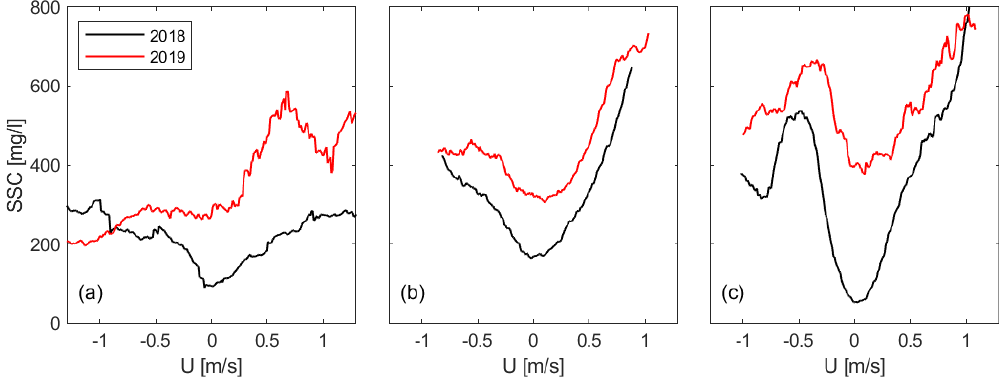
Figure 9. Sediment concentration averaged per eastward flow velocity U (flood currents positive) over a spring–neap tidal cycle for the moored observations in the Dollard: RS_DOL (a) , MC_DOL (b) , and RM_DOL (c) .